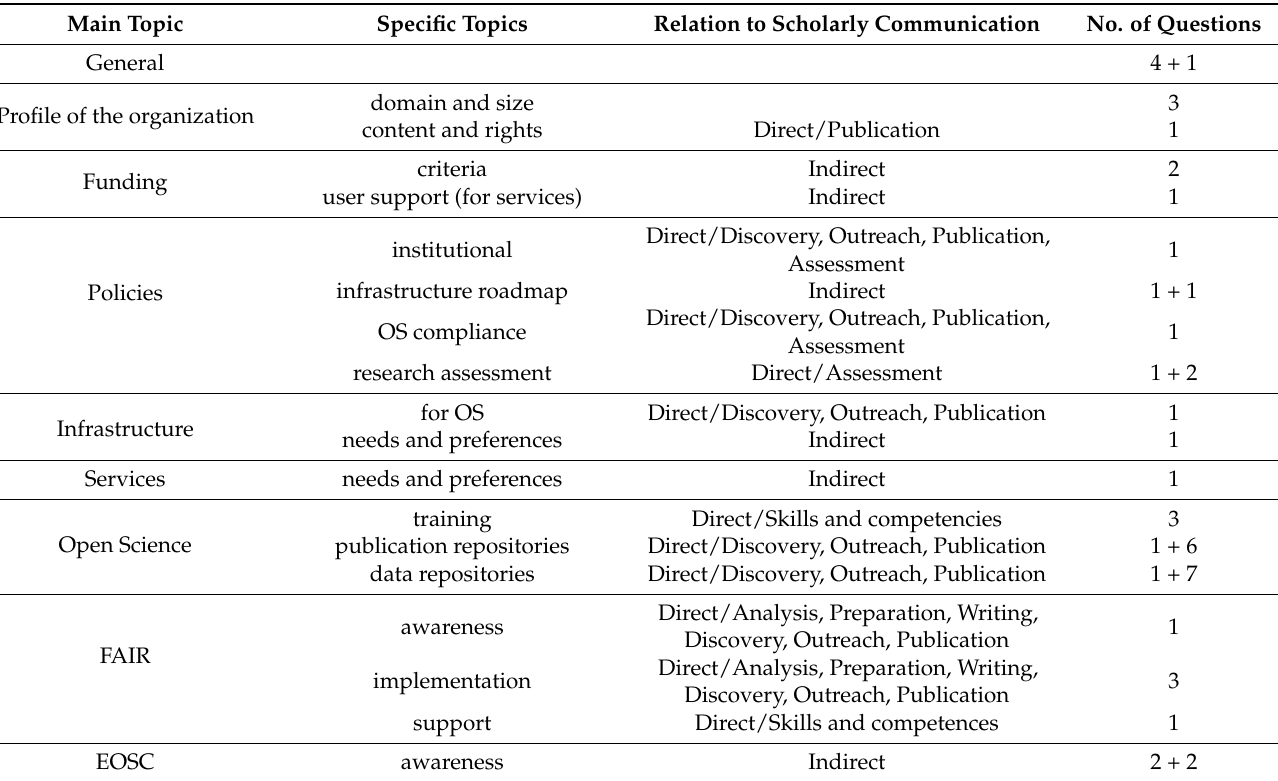
Table 1. Topics covered in the questionnaire for research performing stakeholders: relation to scholarly